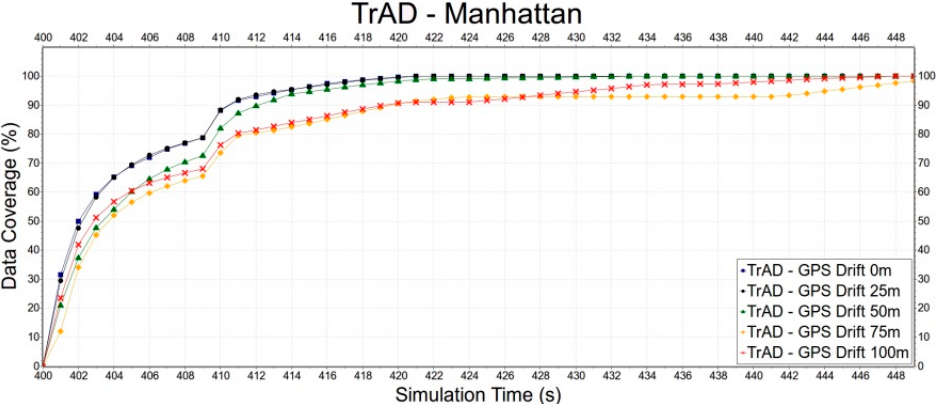
Figure 13. The impact of GPS drift on TrAD in the Manhattan scenario.